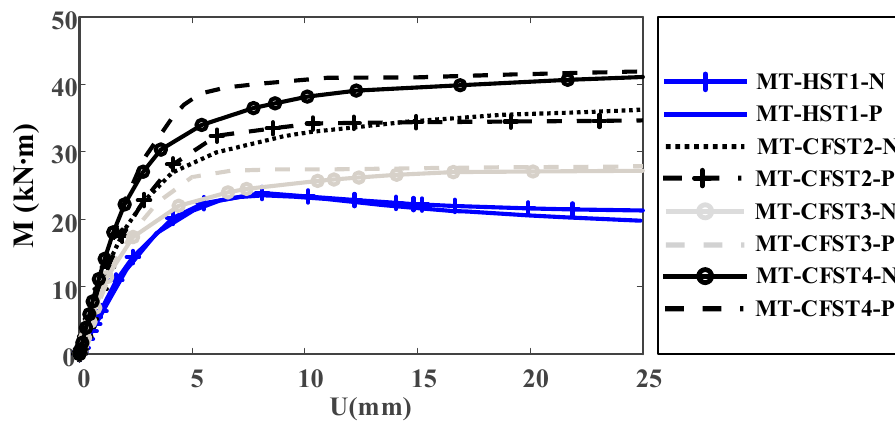
Figure 9. Moment-deflection curves for the tested specimens.